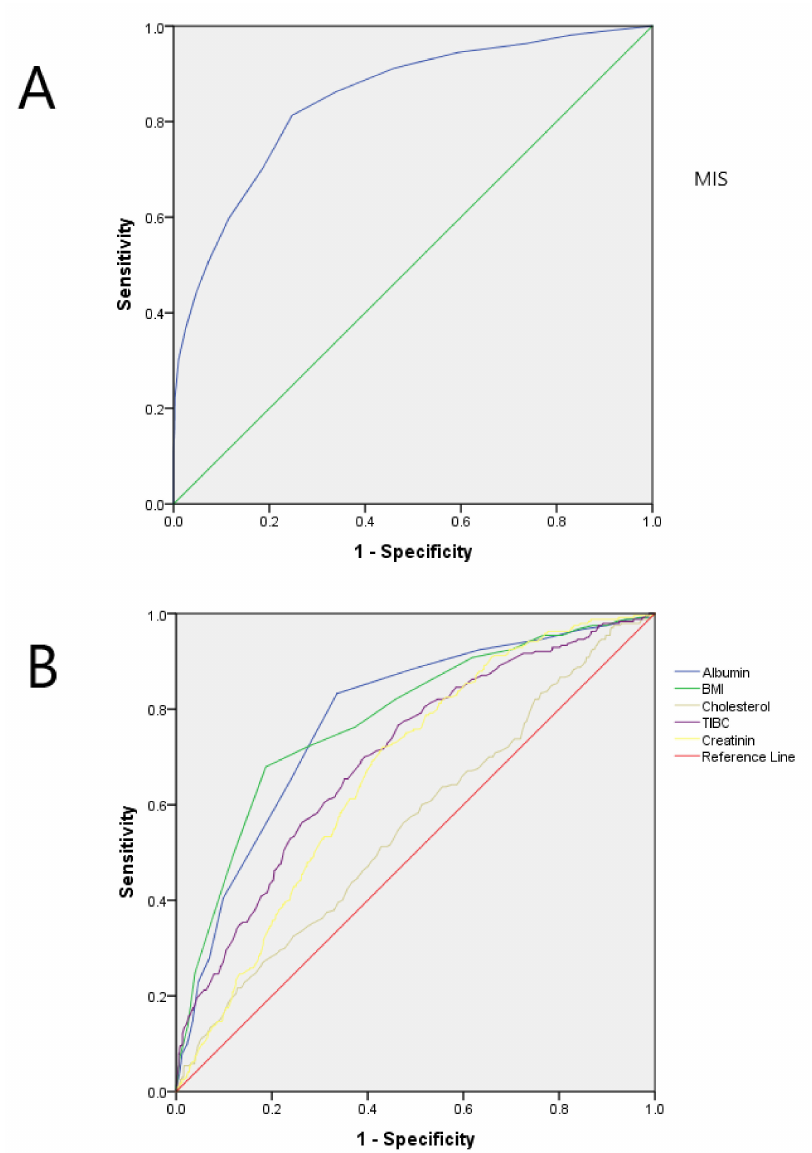
Figure 3. ( A ) Receiver operating characteristic (ROC) curve for malnutrition inflammation score (MIS) for the diagnosis of protein-energy wasting (PEW). Area under the curve (AUC) for MIS is 0.85 with p < 0.001 ( B ) Aggregated receiver operating characteristic (ROC) curves for several malnutrition markers for the diagnosis of protein-energy wasting (PEW). Area under the curve (AUC) for every marker are detailed on Table 3. BMI, body max index; TIBC, total iron binding